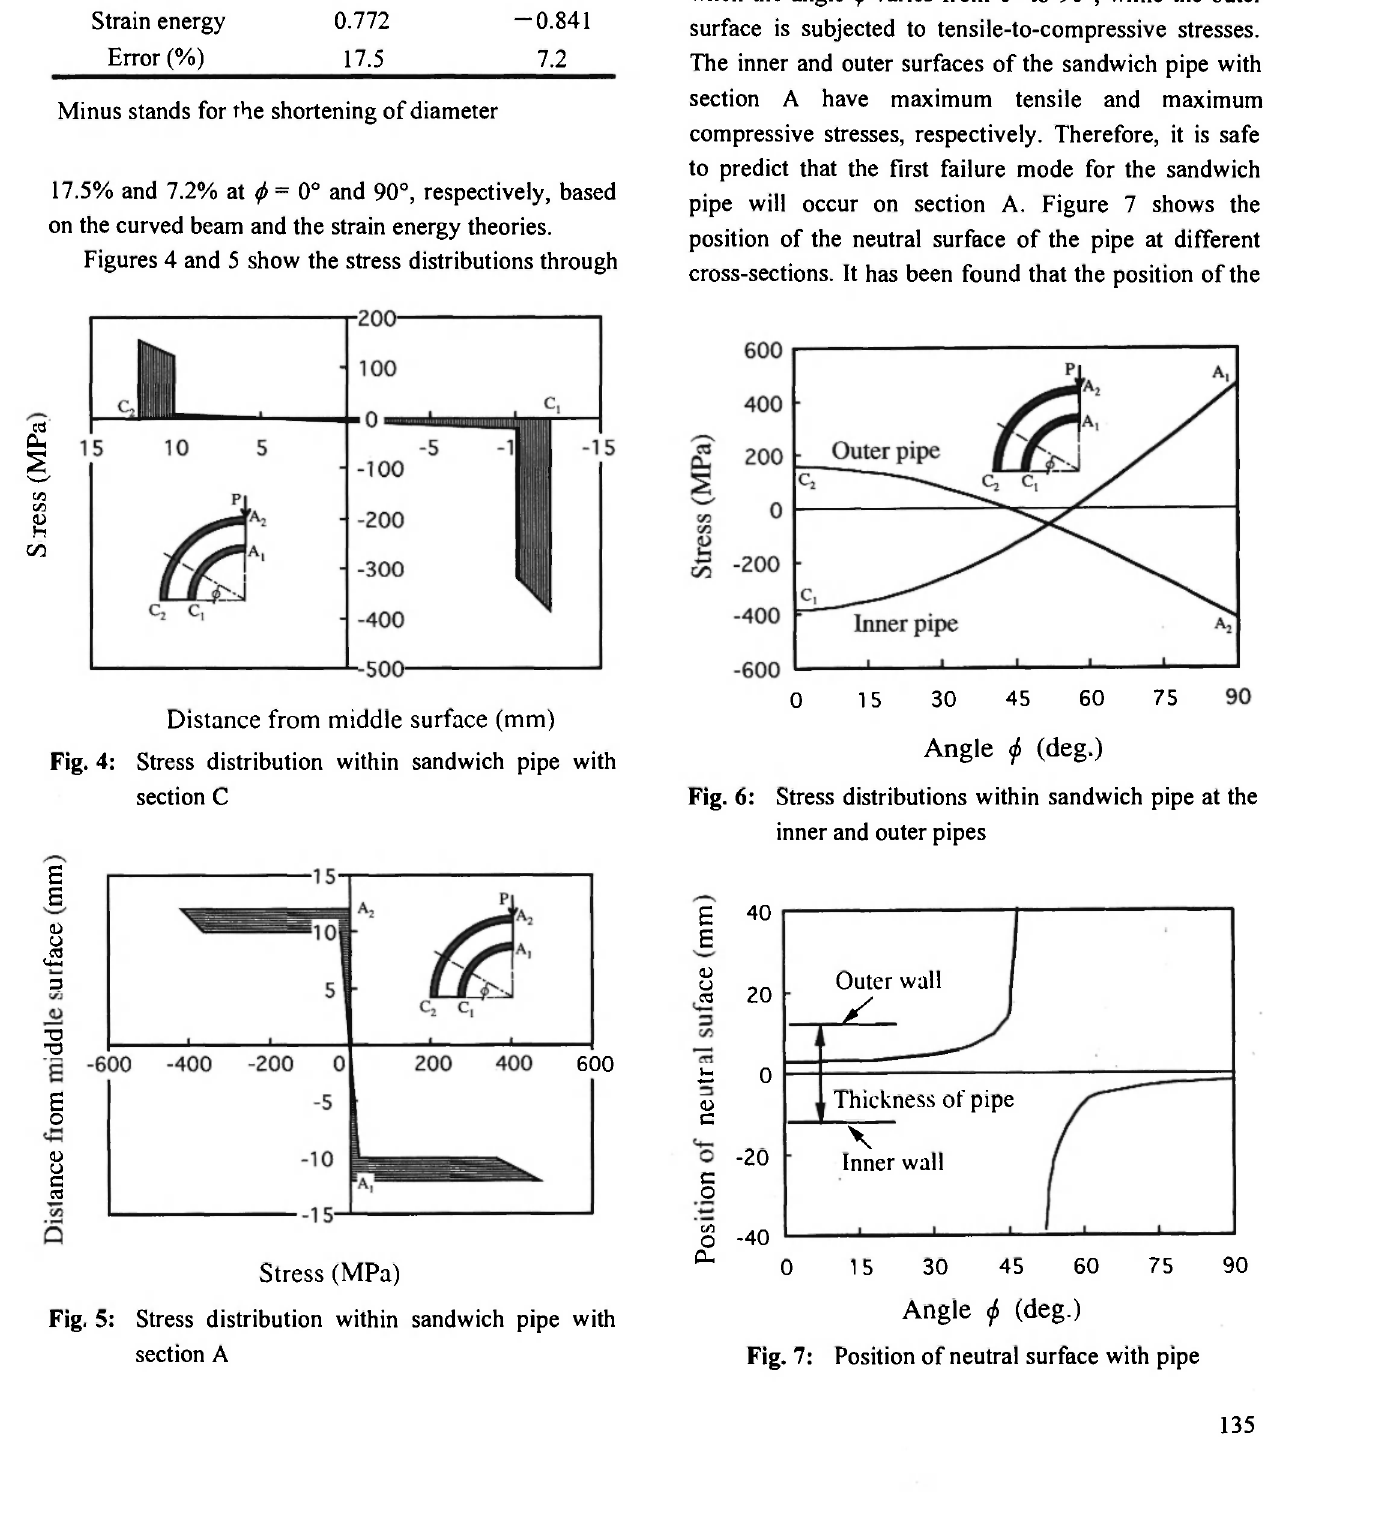
Fig. 7: Position of neutral surface with